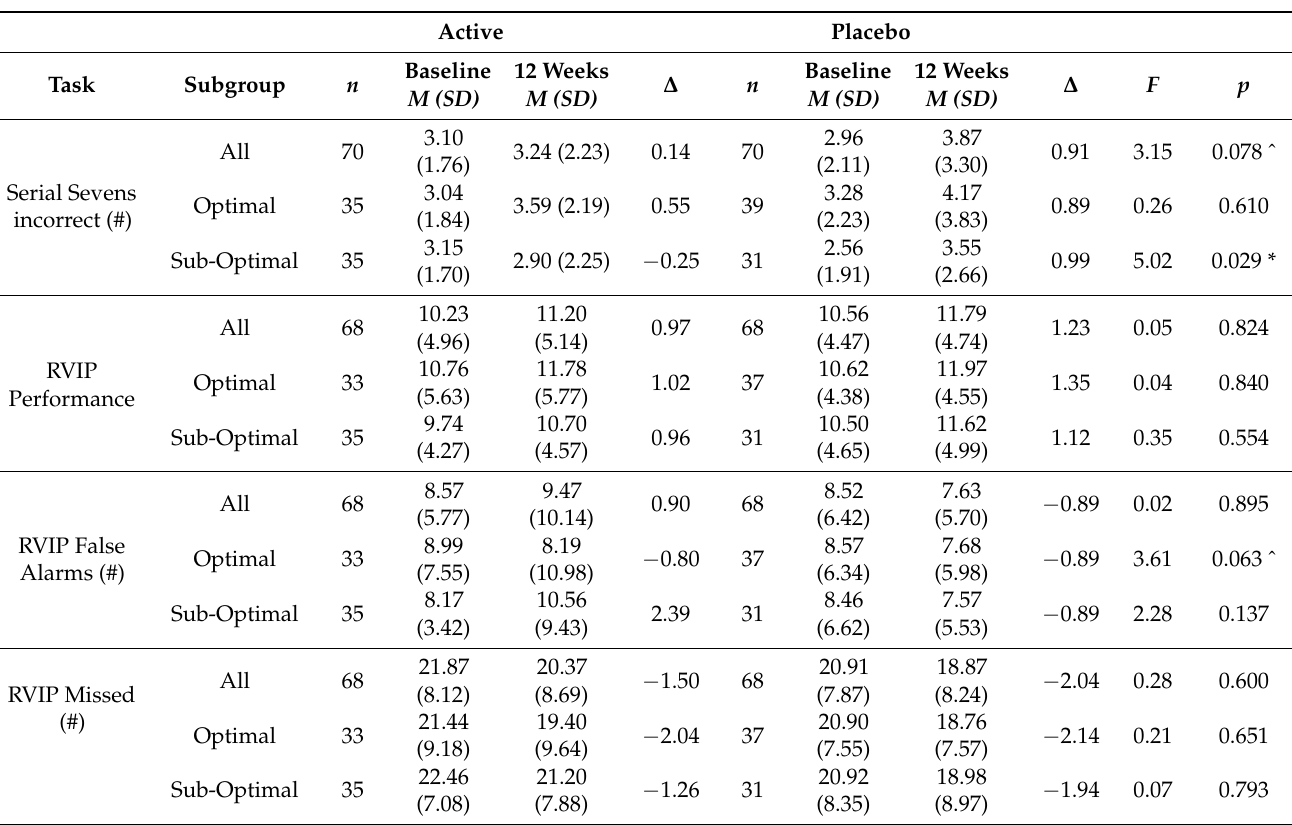
sure. Δ indicates mean change between baseline and 12 weeks. F indicates F value for treatment x time interaction. Performance on each task was computed as accuracy (%) divided by speed of re- sponse (in milliseconds) where higher scores were equivalent to better performance. * p < 0.05, ^ p < 0.10.